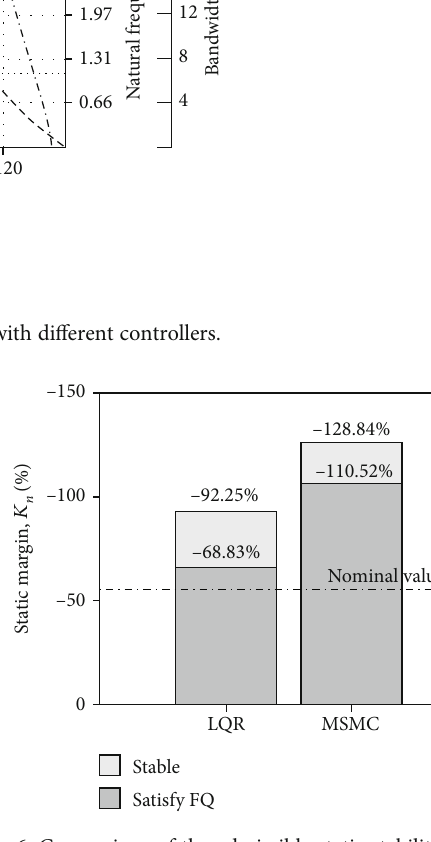
Figure 6: Comparison of the admissible static stability margin for speci fi c input